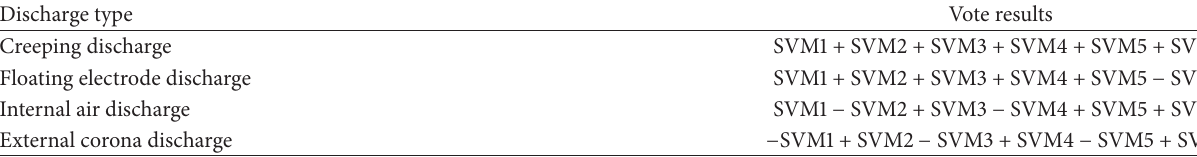
Table 4: Vote results of four discharge types.